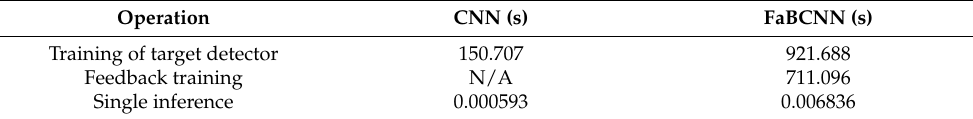
Table 5. Computational time of FaBCNN versus a CNN with the same